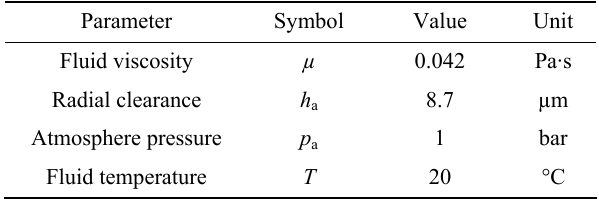
Table 1 Fixed parameters for the